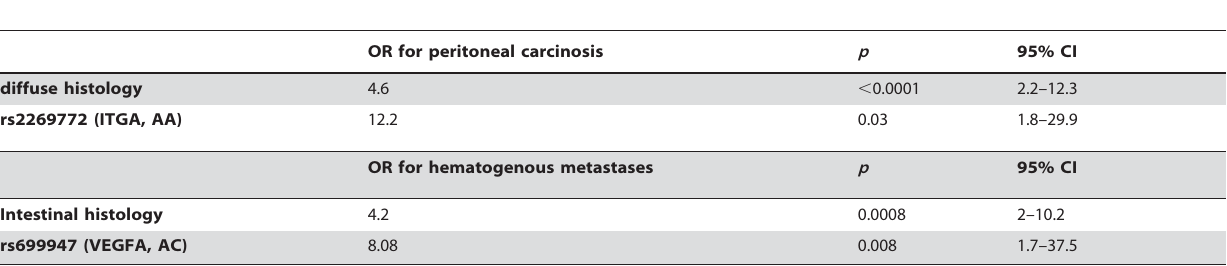
Table 5. Odds ratio results for variables resulted independently correlated with either peritoneal or hematogenous metastases at multivariate